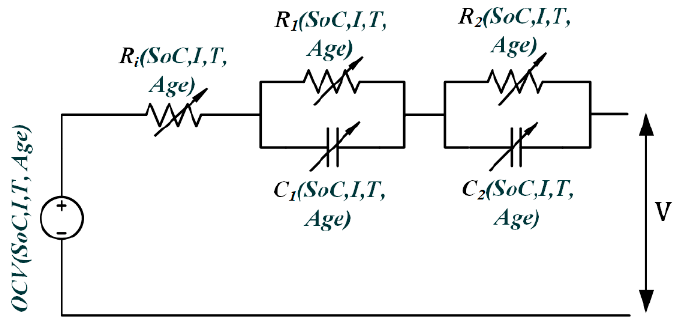
Figure 2. Second-order equivalent circuit (SOEC) battery cell model.